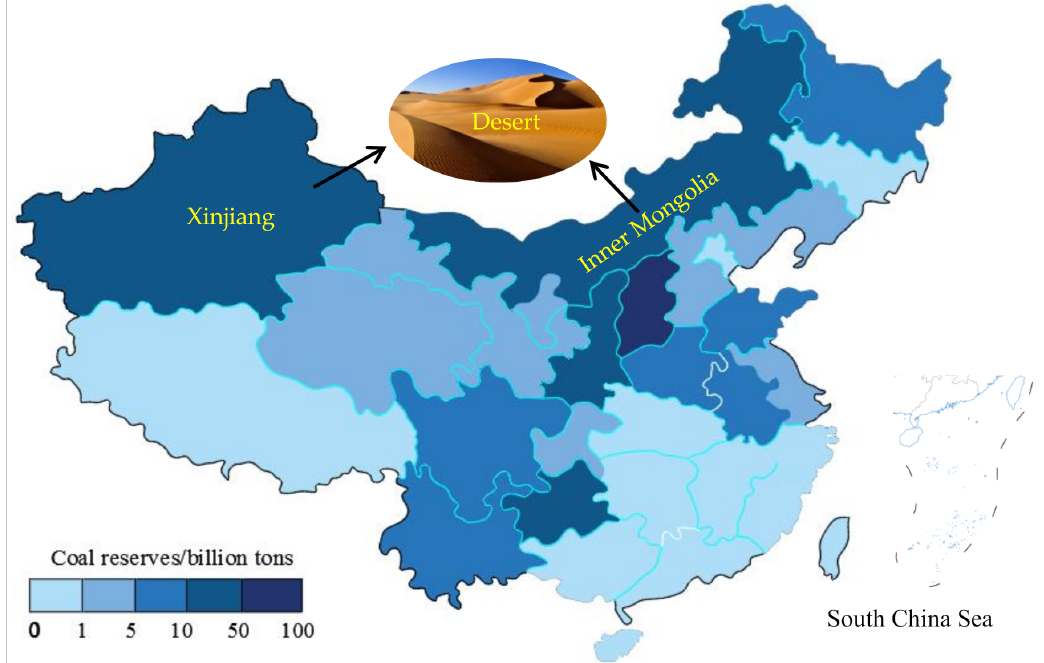
Figure 1. Distribution of coal resources in China.